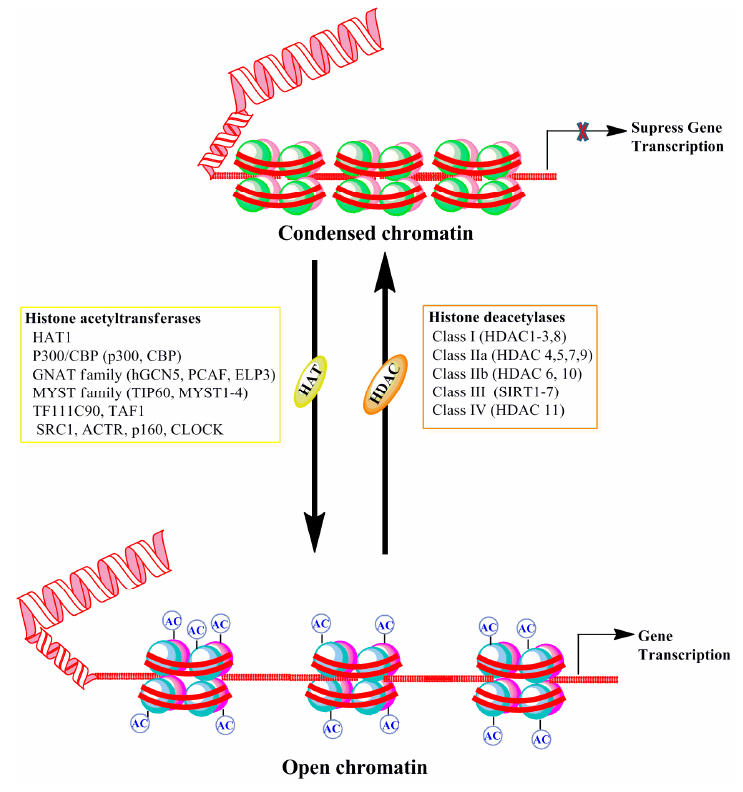
Figure 2. Schematic representation of DNA-associated histone protein acetylation and deacetylation by histone acetyltransferase (HAT) and histone deacetylase (HDAC) enzyme families. The net acetylation at lysine residues of histone proteins of nucleosomes is decided by the interplay between acetylation and deacetylation processes through HAT and HDAC enzyme activities, respectively. The box provides different families and classes of HAT and HDAC enzymes. CBP, cyclic adenomonophosphate response element-binding (CREB) binding protein; GNAT, Gcn5-related N -acetyltransferases; hGCN5, human general control of amino acid synthesis protein 5-like 2; PCAF, p300/CBP-associated factor; ELP3, elongation protein 3; TIP60, TAT interacting proteins 60; TFIIIC90, transcription factor IIIC 90kDa; TAF1, TATA Box Binding Protein-Associated Factor; SRC1, steroid receptor coactivator 1; ACTR, activator of thyroid receptor; p160, receptor coactivators proteins 160; CLOCK, Clock Circadian